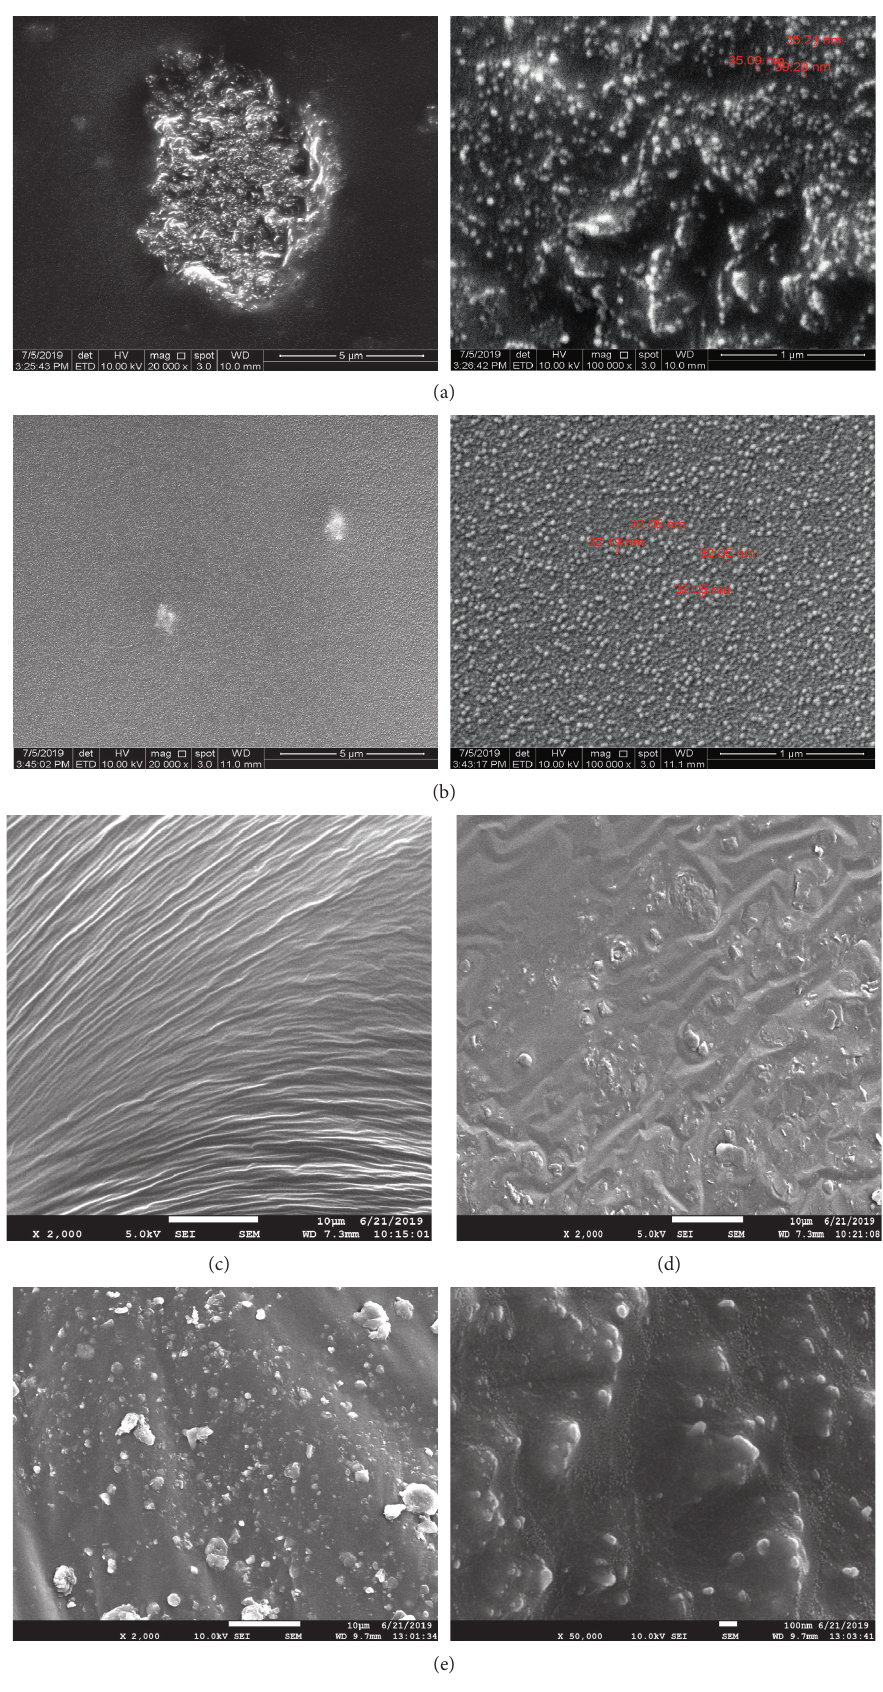
Figure 2: The SEM images of base asphalt and modified asphalt. (a) Unmodified nano-ZnO modified asphalt. (b) Surface-modified nano- ZnO modified asphalt. (c) Base asphalt. (d) SBS-modified asphalt. (e) 4# modified